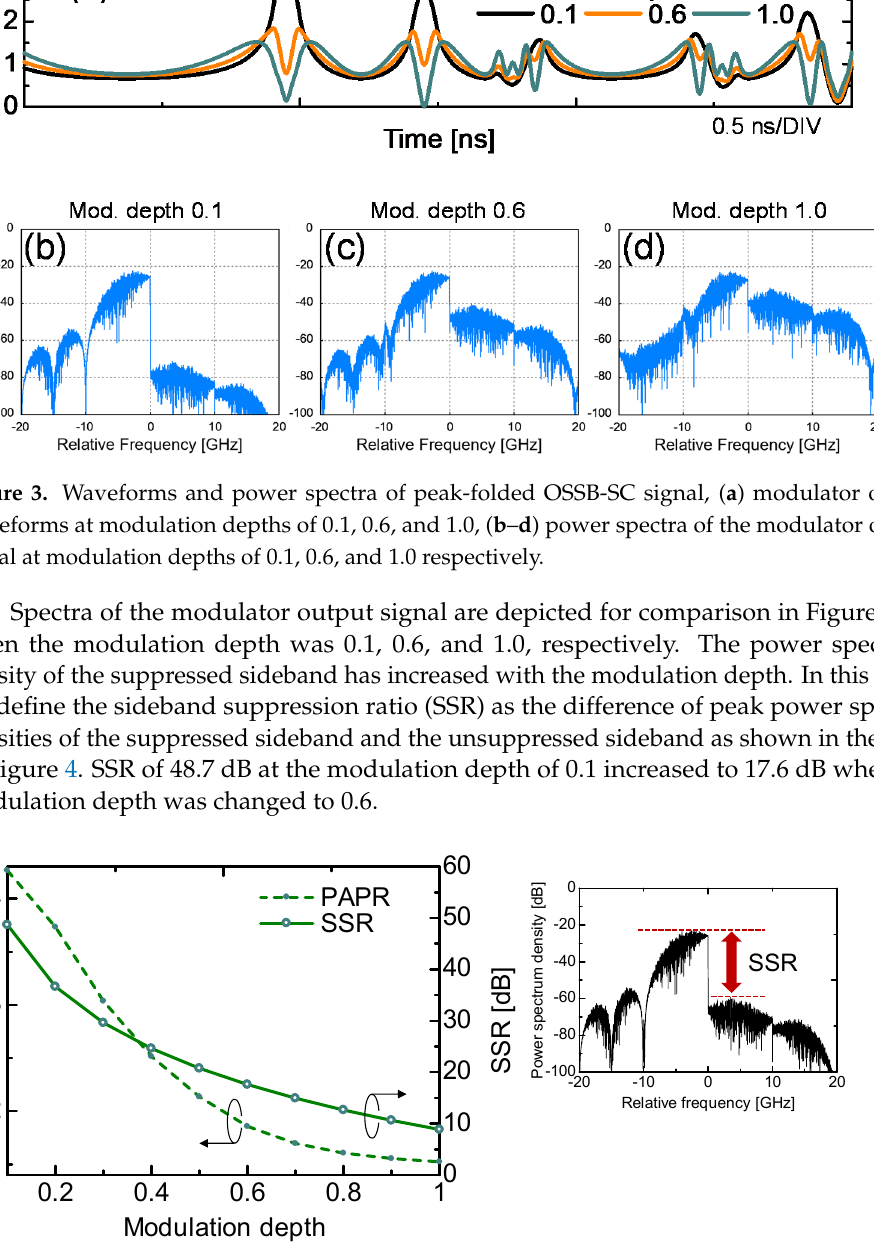
Figure 4. PAPR and SSR characteristics of peak-folded OSSB-SC signal, inset; definition of sideband suppression ratio (SSR).